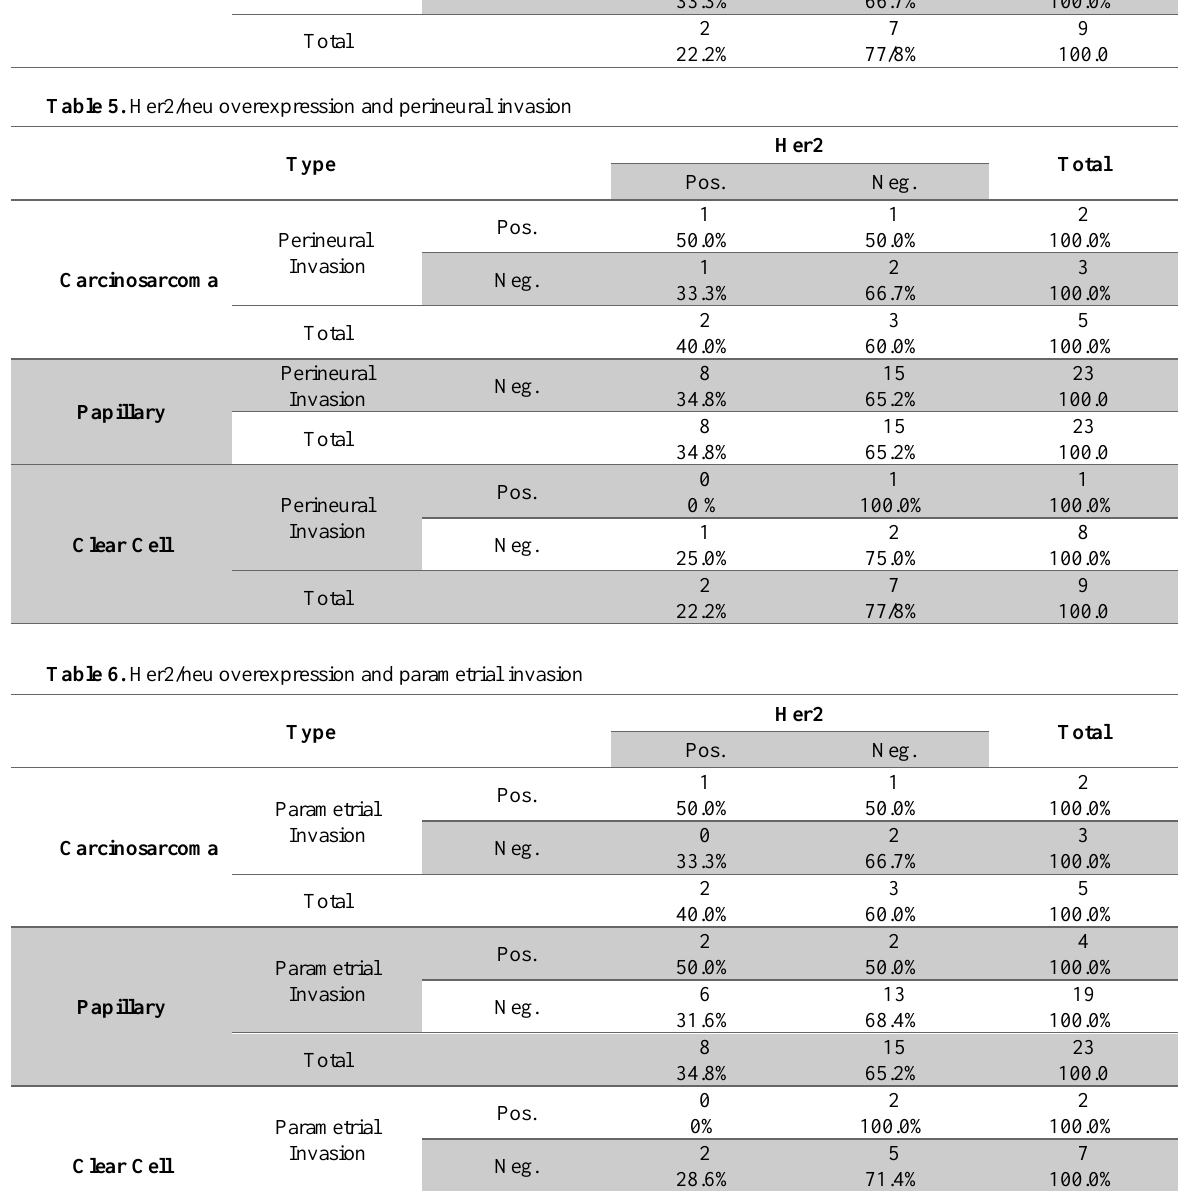
Table 5. Her2/neu overexpression and perineural invasion Type